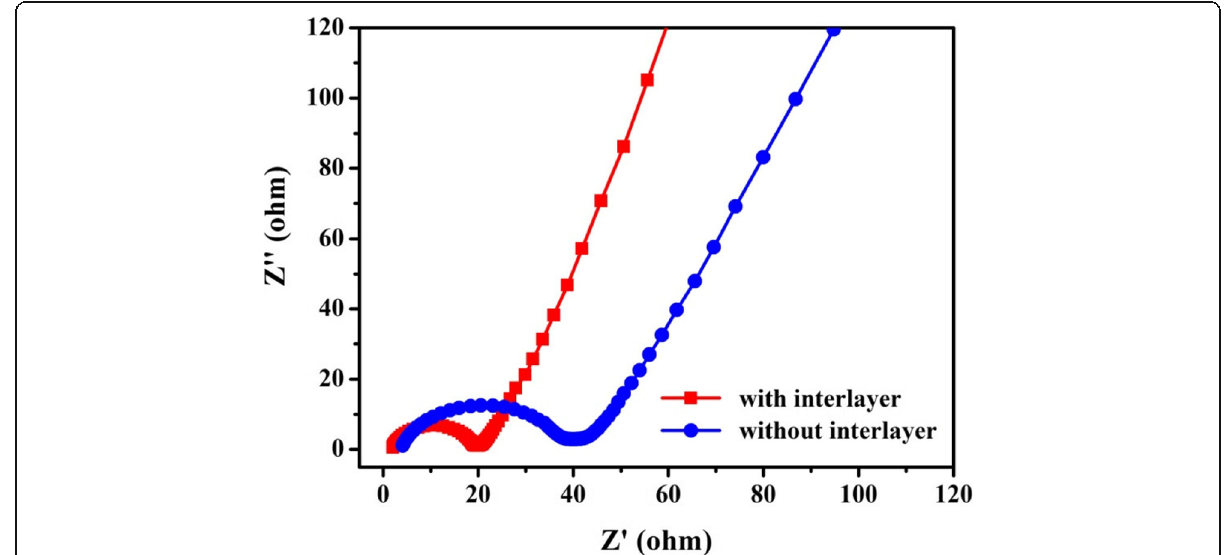
Fig. 6 Nyquist plots for cells assembled with and without CeO 2 /RGO composite coated